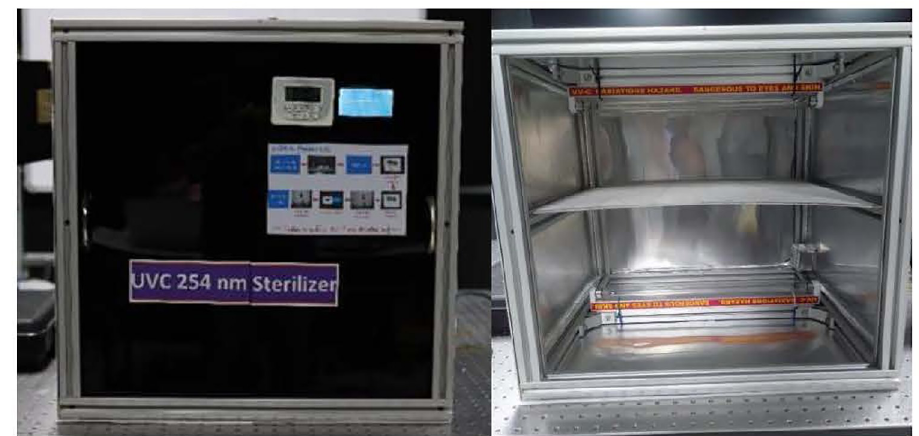
Fig 2. UVC halogen lamp (Philips UV-C 30 Watt 2 P